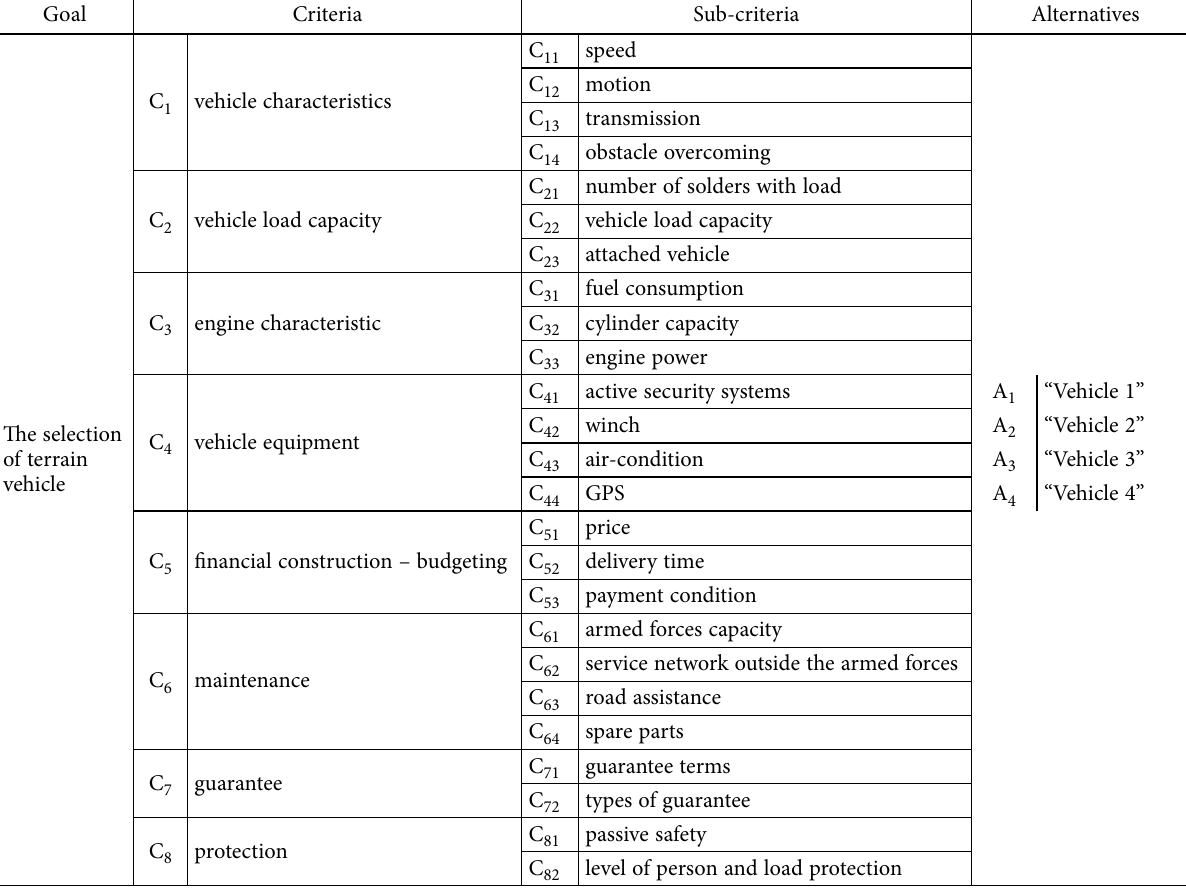
Table 1. Main criteria and